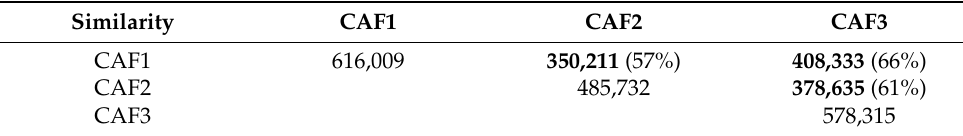
Table 1. Similarity evaluation of three CAF peptide selections at threshold 0.68. Given are the total numbers of peptides of the repertoires, and in bold the numbers of peptides in the peptide-to-peptide mapping between the repertoires using the PAM30 score; and the corresponding percentages of peptides in the repertoires with similarity at 0.68